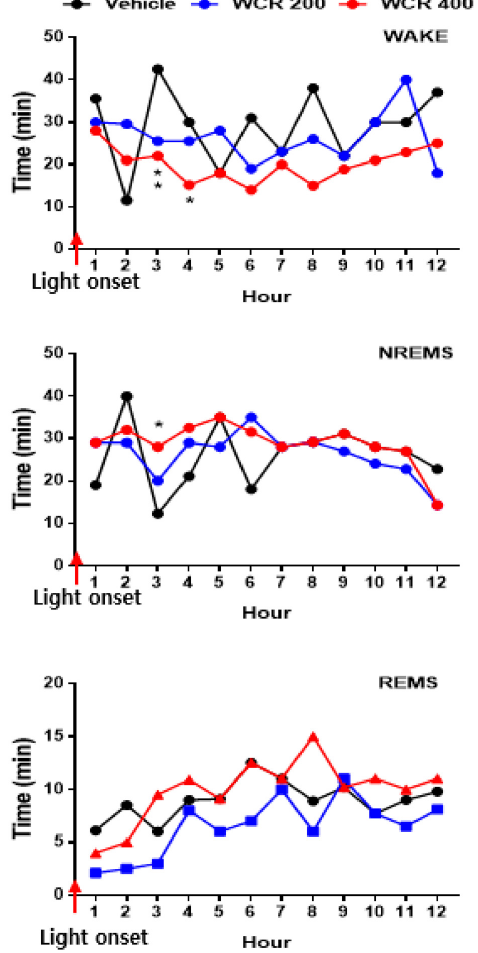
Figure 6. Time course of wake, NREM sleep, and REM sleep after treatment with WCR. Each circle displays the hourly mean ± SEM. * p < 0.05, ** p < 0.01, significantly different compared with the vehicle group. ANOVA followed by Tukey’s test. The CON group: treatment with the vehicle; the WCR groups: treatment with WCR (200 or 400 mg/kg).